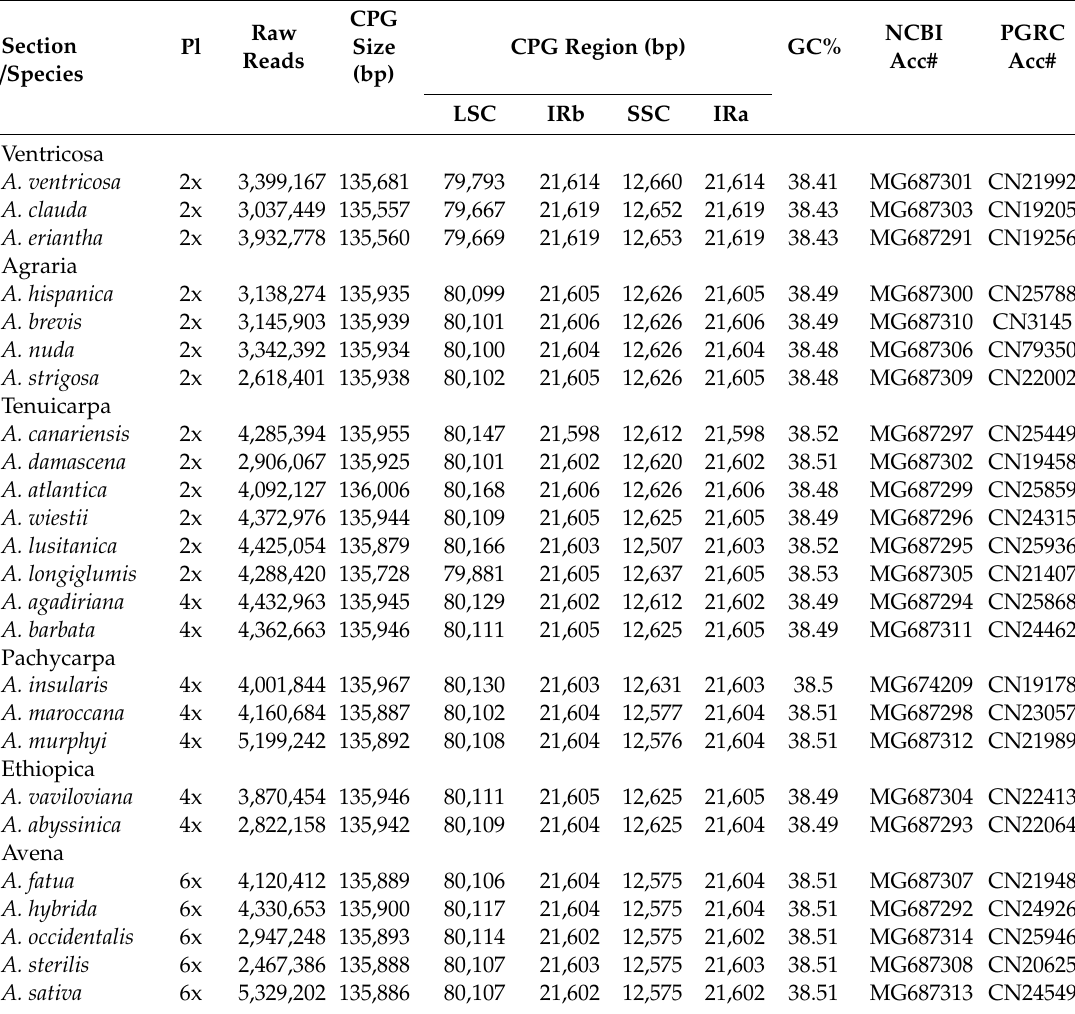
Table 1. List of 25 studied Avena species from six botanical sections and their cp genome